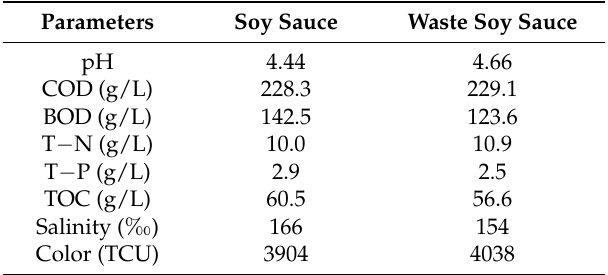
Table 3. Chemical composition of soy sauce and waste soy